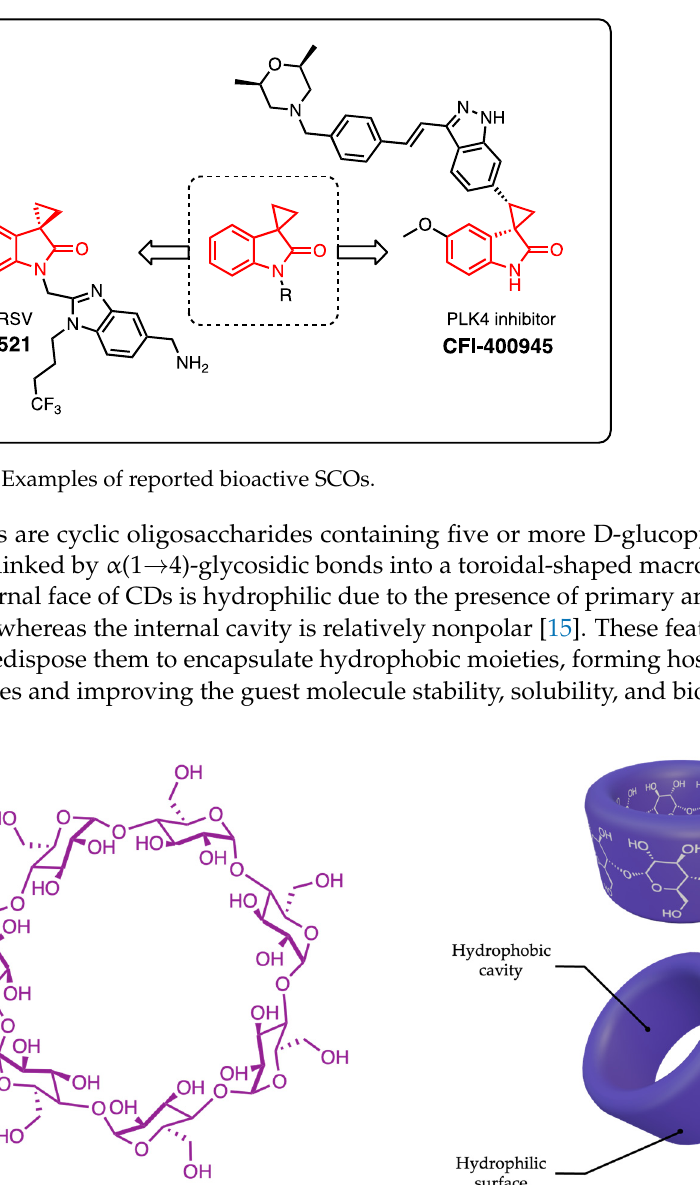
Figure 1. Examples of reported bioactive SCOs.